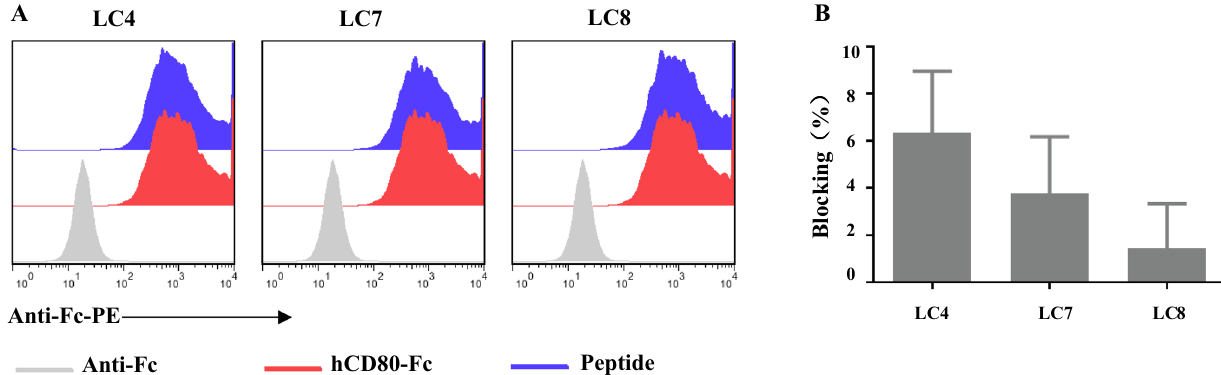
Fig. 3 The CTLA-4 binding peptide effect on CTLA-4/CD80 interaction was determined via cell-based blocking assay. CTLA-4 binding pep- tide at 200 μM was incubated with CHO-K1/hCTLA-4 cells for 30 min, followed by incubation with 10 ng human CD finally, anti-human IgG Fc-PE antibody 0.3 μL was added. The fluorescence intensity detected by flow cytometry was used to calculate the blocking